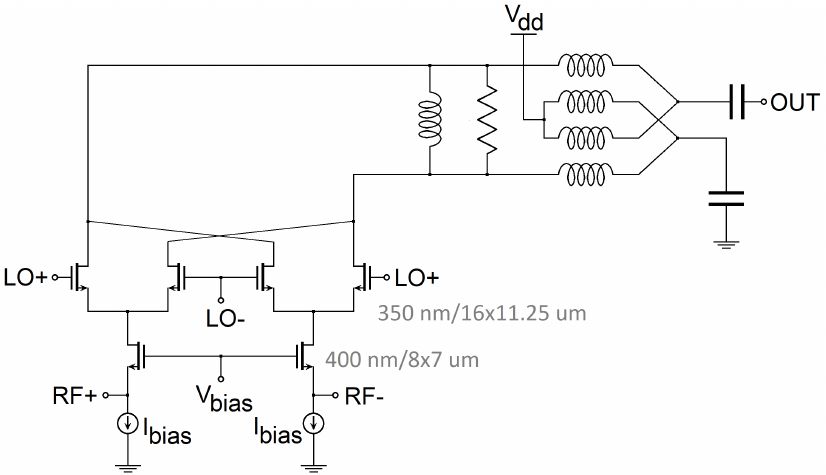
Figure 6. Circuit diagram of the mixers.